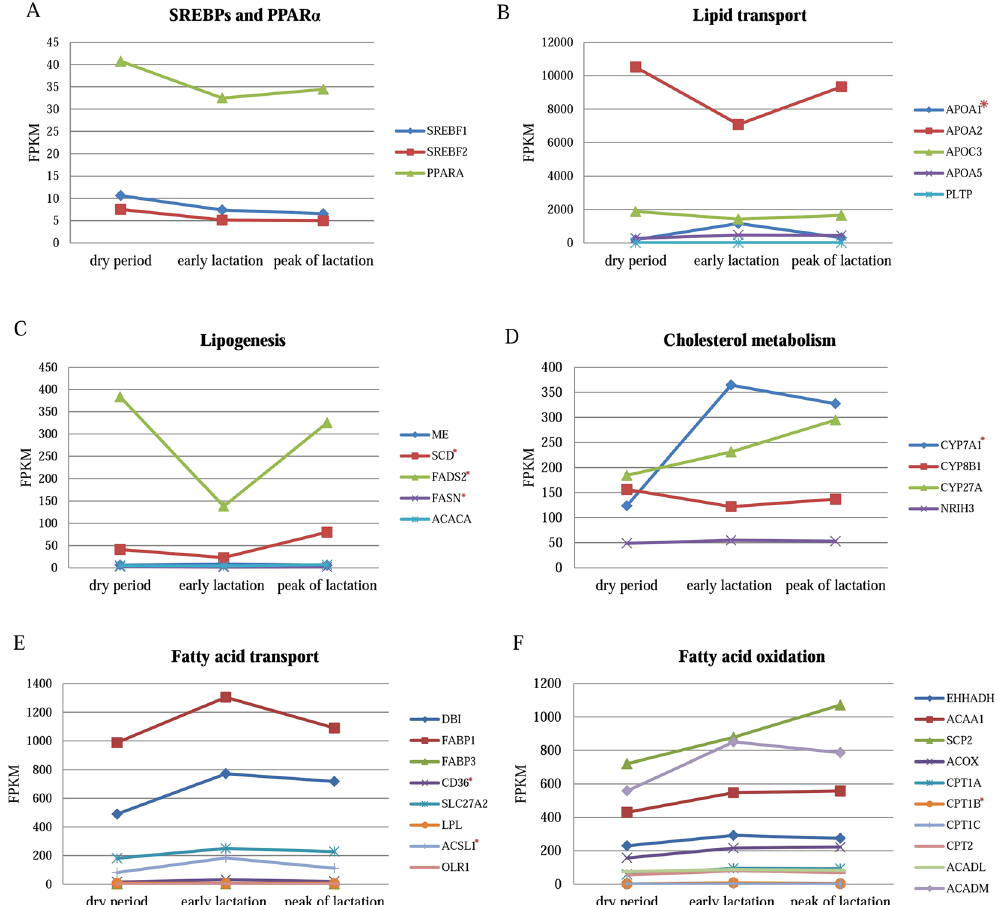
Figure 4. Expression profiles of the lipid metabolic genes during dry period, early lactation, and peak of lactation. The expression levels of lipid metabolic genes are shown based on FPKM values; the genes are divided into SREBPs and PPAR α ( A ), lipid transport ( B ), lipogenesis ( C ), cholesterol metabolism ( D ), fatty acid transport ( E ), and fatty acid oxidation ( F ) categories; and the differentially expressed genes are labeled with an